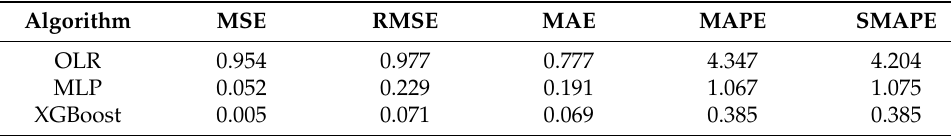
Table 6. Evaluation indexes of each algorithm in Beijing.